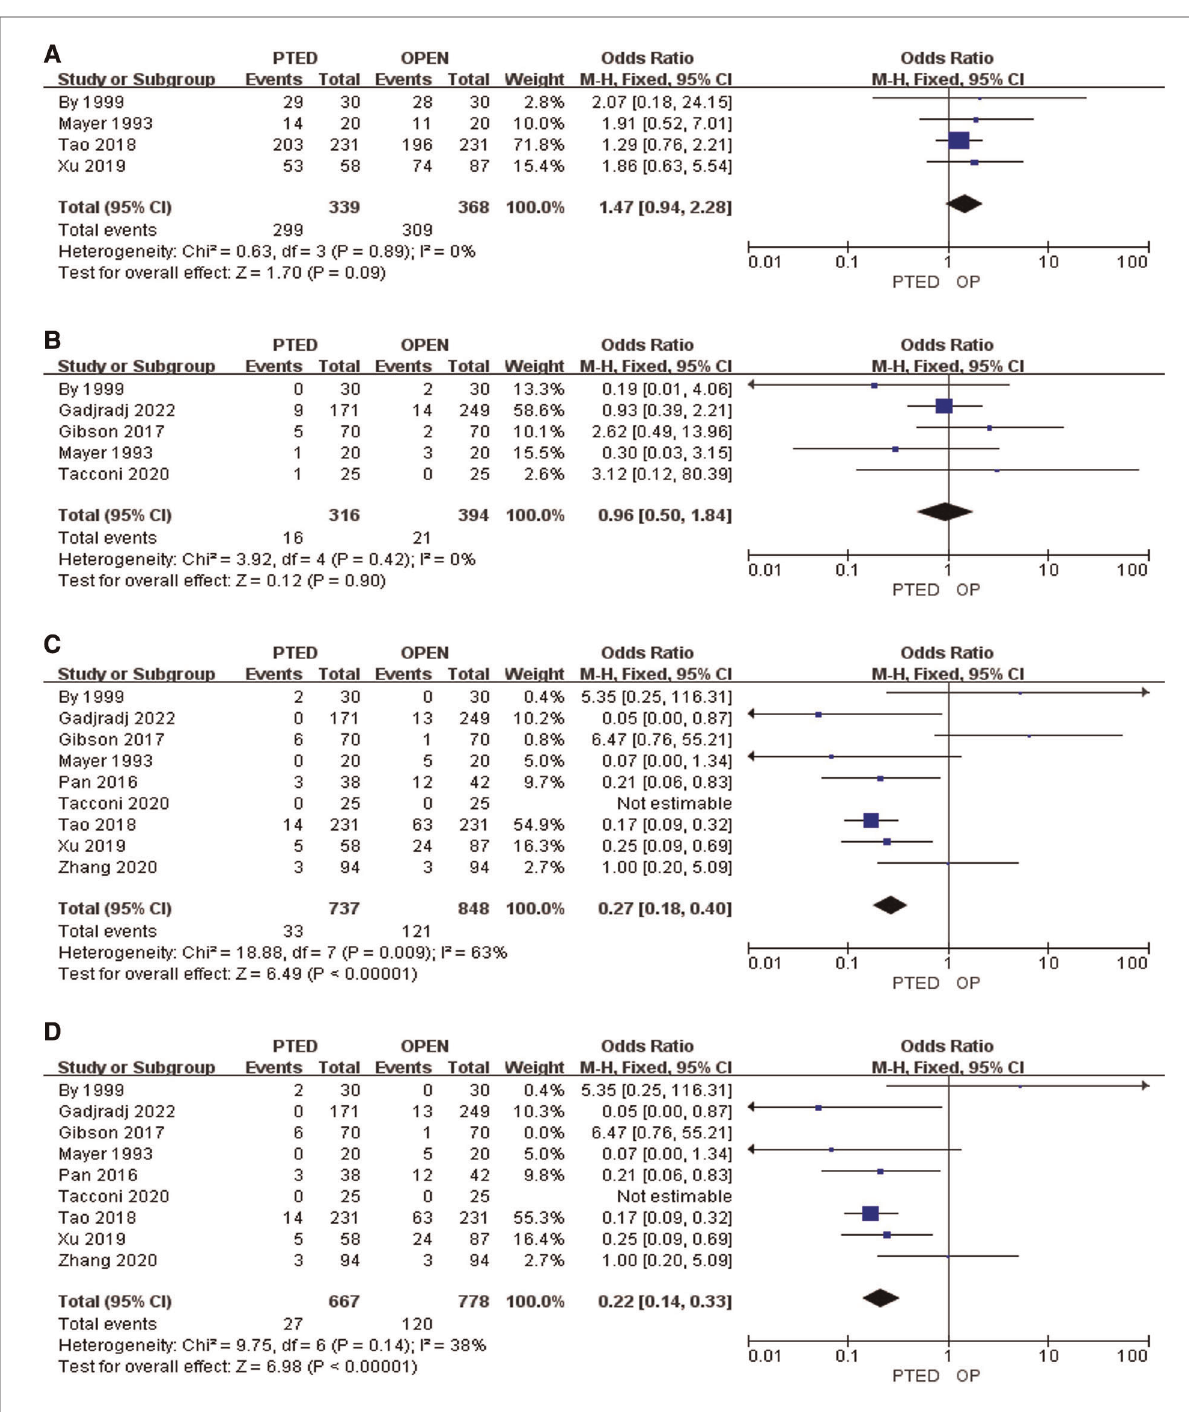
FIGURE 2 Pooling results of the PTED group and the OLD group. ( A ) Excellent rates; ( B ) Reoperation rates; ( C ) Complication rates; ( D ) Complication rates after sensitivity